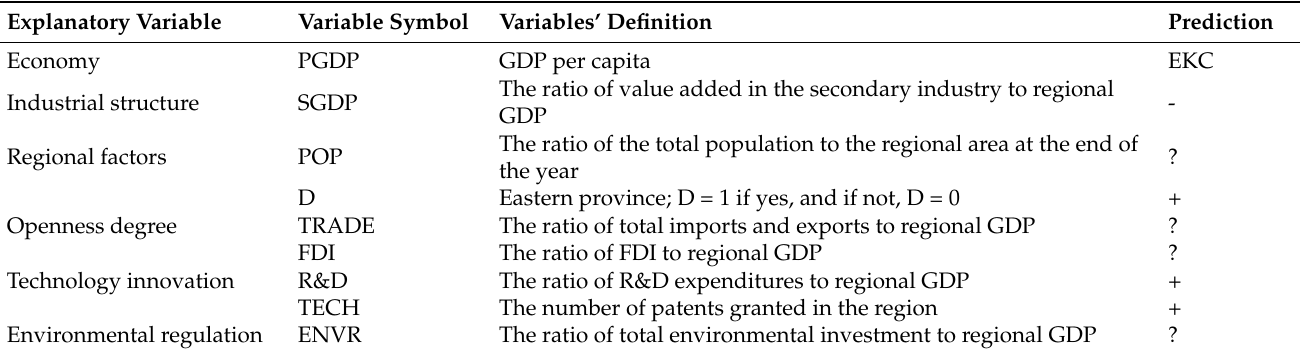
Table 4. Influencing factors and their relevant